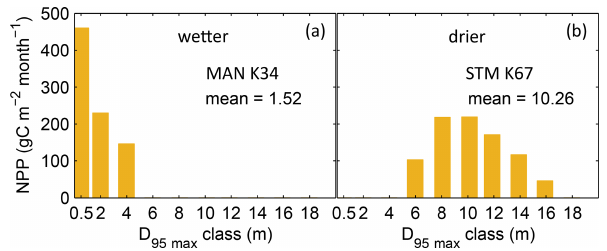
Figure B3. Distributions of simulated mean monthly NPP for each D 95_max class for 2001–2010 under CRU climate input at two FLUXNET sites. (a) Site MAN_K34 near the city of Manaus. (b) Site STM_K67 near the city of Santarem. For more site informa- tion, see Table A3 and Fig. B6a. At the FLUXNET site MAN_K34 (a) , which exhibits a mean annual precipitation (MAP) of 2609mm and a mean MCWD of − 222mm under CRU climate input (2001– Figure B5. Mean rooting depth depicted as mean D 95 over classes 2010), the sub-PFT with a maximum rooting depth D 95_max of of MCWD and annual precipitation sums. Class step size for pre- 0.5m contributes most to overall NPP and the whole distribution cipitation was set to 250mm, and class size for MCWD was of NPP-weighted D 95_max classes shows a mean of 1.52m. At the set to 50mm. Regions with high amounts of annual rainfall and FLUXNET site STM_K67 (b) , which exhibits a lower MAP of lower seasonality exclusively favour shallow-rooted forests (low 2144mm and a stronger dry season reflected in a mean MCWD of D 95 ). D 95 increases with decreasing MCWD (increasing seasonal − 465mm, the NPP-weighted distribution of D 95_max shows a peak drought stress) and decreasing sums of annual precipitation. Below at 10m and a corresponding mean of 10.26m. Since both sites have 1200mm of annual rainfall or − 1100mm of MCWD, D 95 sharply a soil depth of 20m (according to the soil depth input; Sect. 2.3.2, decreases again. Note this figure does not consider soil depth. The Fig. A3) differences in rooting strategy compositions must emerge colour-scale maximum is set to from the climatic differences in those sites. It is important to note that D 95_max values (i.e. the bins on the x axes) do not necessar- ily reflect the true rooting depth achieved by each sub-PFT but their maximum value. For reasons of visual clarity, for this figure we kept the bins of the x axes as chosen in Table A2.